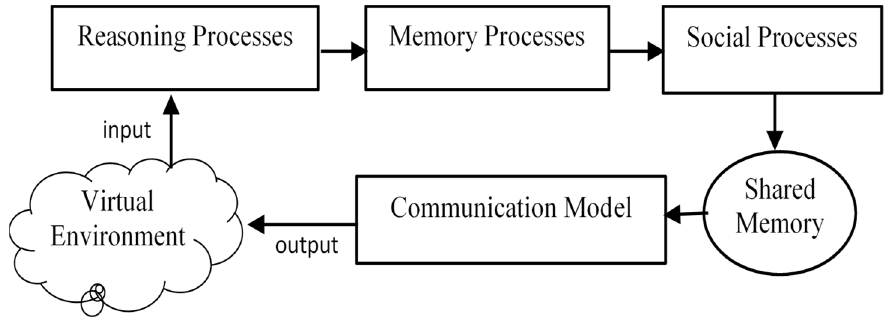
Figure 2. High-level agent architecture with pipe and filter design and communication model connected via a blackboard situated in a collaborative virtual environment.